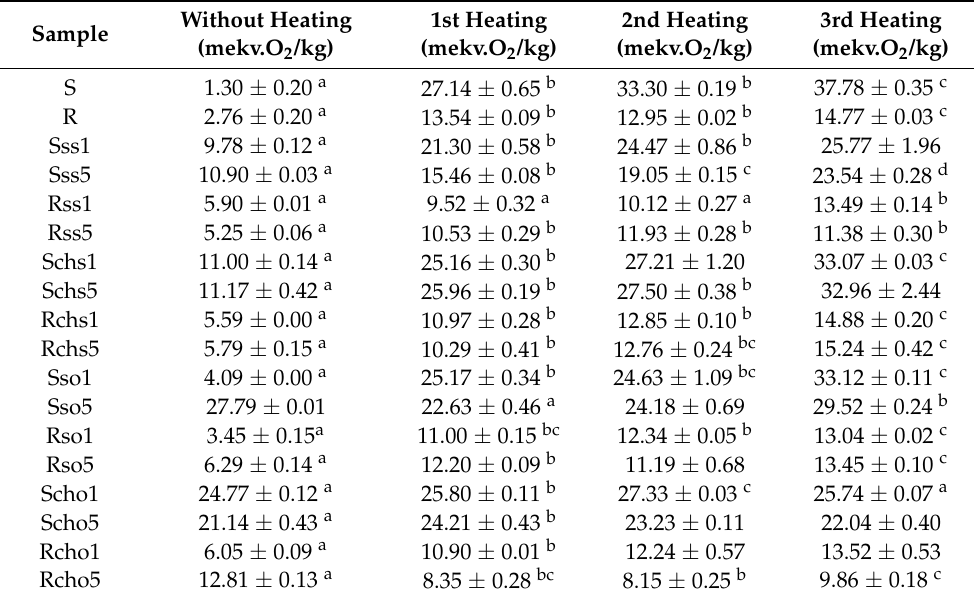
Table 5. Oxidation degree of fortified oil samples after repeated cycles of heating. Without Heating Sample (mekv.O 2 /kg)